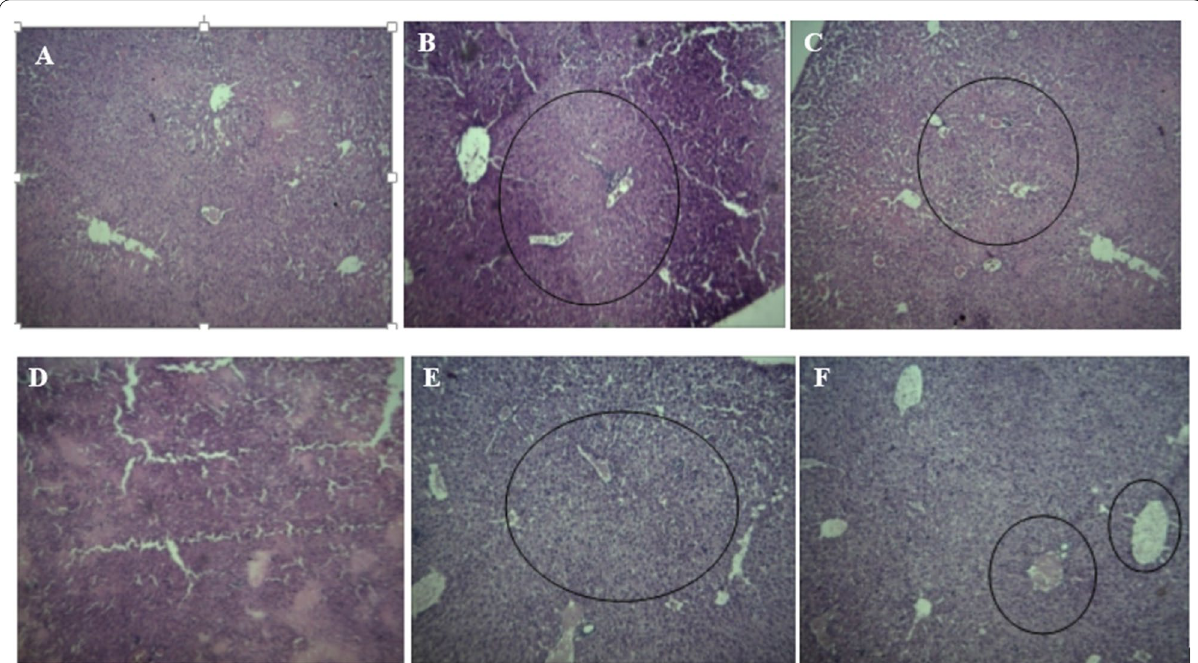
Fig. 3 Cross section of liver of female albino mice infected with P. berghei and administered B distilled water, C 5 mg/Kg/day of chloroquine, D 125 mg/Kg/day, E 250 mg/Kg/day, F 500 mg/Kg/day of aqueous extract of Blighia sapida leaves. A Normal control (